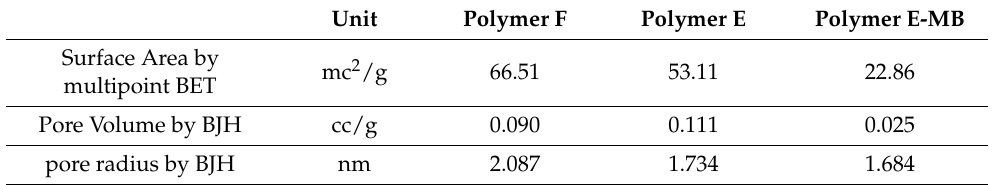
Table 2. Surface area, pore volume and radius of polymer F, polymer E, and MB adsorbed on polymer